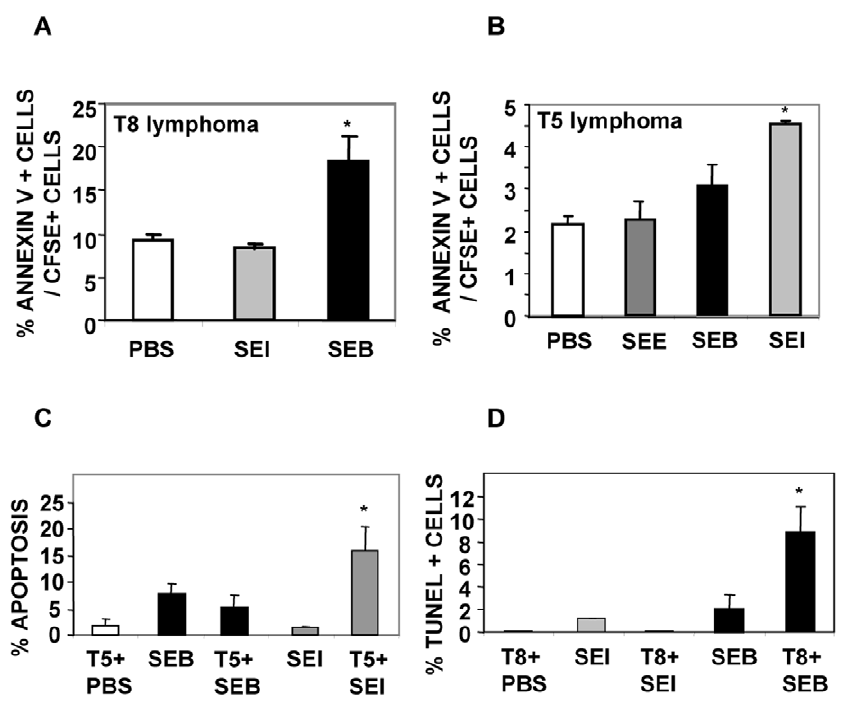
Figure 4. Sags increase apoptosis of cognate lymphoma T cells invivo . (A–B) AKR/J mice were intraperitoneally inoculated with 5 6 10 6 CFSE- labeled T8 or T5 cells. One hour later 25 m g of SEE, SEI, SEB or PBS were intraperitoneally administered. After 48 hours, cells were recovered and the percentage of Annexin V + cells/CFSE + cells was assessed by FACS. Data are expressed as the mean 6 SD, n=4 per group. *p , 0.05. (C) AKR/J mice were inoculated in the footpad with 0.3 6 10 6 T5 cells and 6 days later mice were footpad injected with 10 m g of the indicated Sag or PBS. Twenty four hours later PLN were removed and the percentage of apoptotic cells was determined by evaluating the percentage of hypodiploid nuclei by PI staining. Data are expressed as the mean 6 SD, n=4 per group. * p , 0.05. (D) AKR/J mice were inoculated in the footpad with 0.3 6 10 6 T8 cells and 3 days later they were treated with 10 m g of the indicated Sag or PBS. Normal AKR/J mice were also inoculated with Sags or PBS. Twenty four hours later PLN were removed and paraffin-embedded. PLN were processed for apoptosis detection using a peroxidase-conjugated in situ TUNEL assay. Quantitative studies were performed in a blinded fashion using light microscopy on five or more fields in each sample. Original magnification 6 400. Data are expressed as the mean percentage of TUNEL-positive cells 6 SD, n=4 per field. * p , 0.05. All the experiments were performed three times and gave similar results.